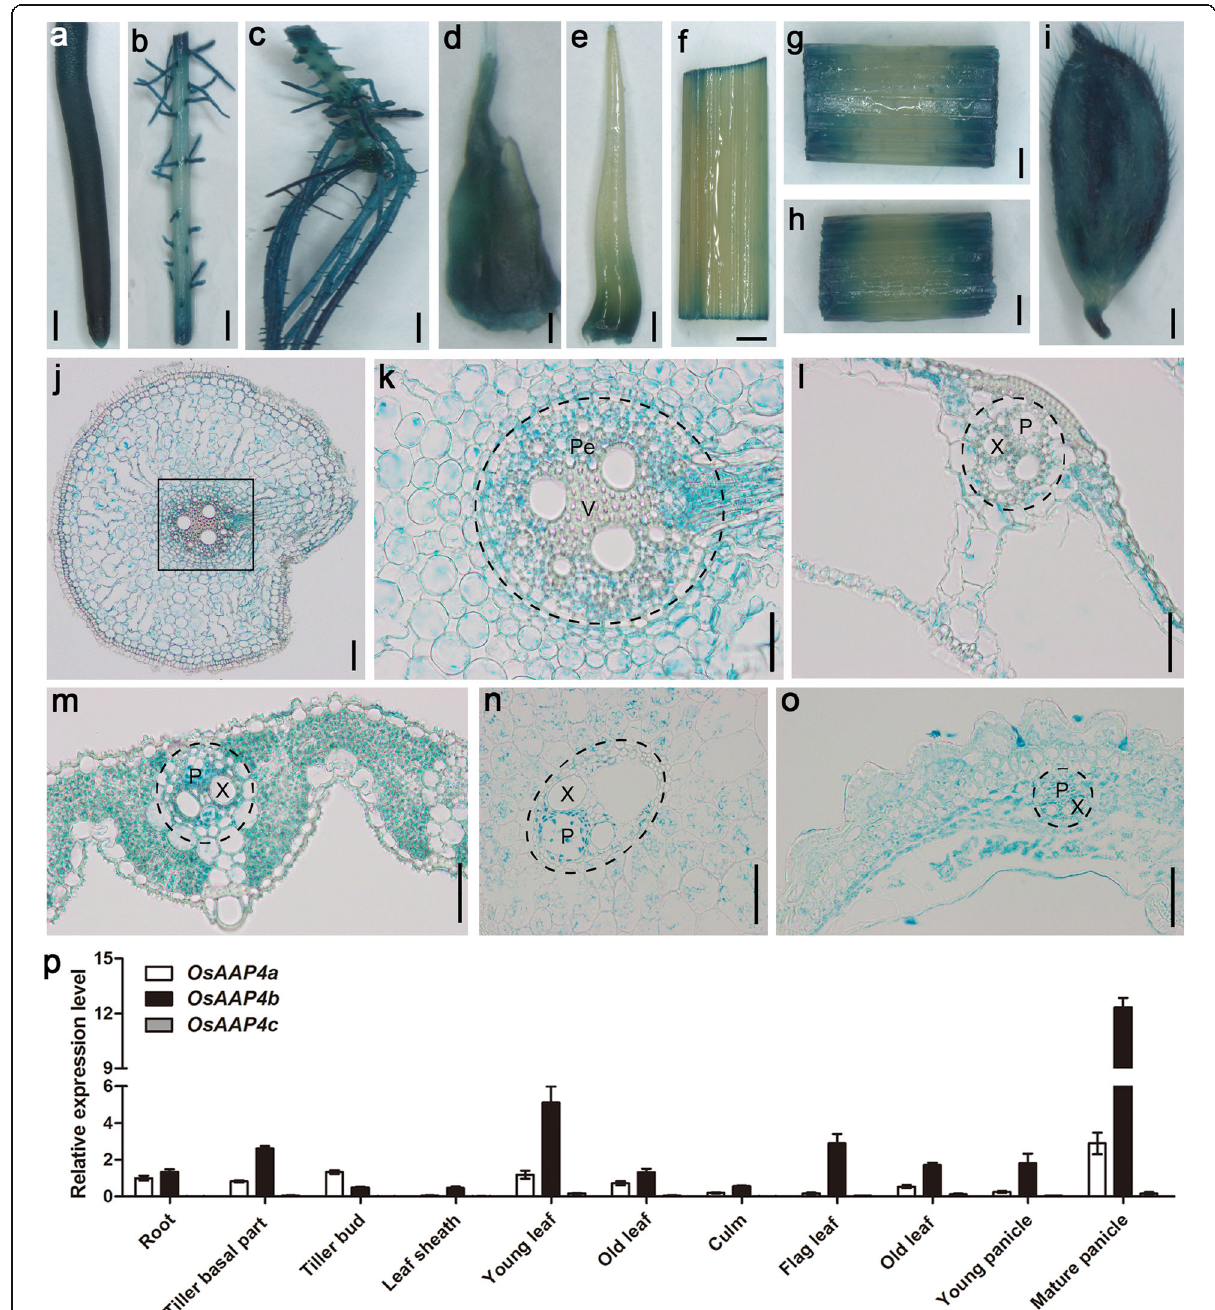
Fig. 2 Promoter-GUS analysis and relative expression level of OsAAP4. OsAAP4 promoter - GUS staining in the root tip ( a ), lateral root ( b ), adventitious roots ( c ), short outgrowth bud ( d ), long outgrowth bud ( e ), leaf blade (f ), leaf sheath ( g ), stem ( h ), and panicle ( i ) using the Hap2- Indica type of p OsAAP4 - GUS- transgenic plants. Transverse section of a root ( j ) and its enlargement ( k ), leaf sheath ( l ), leaf blade ( m ), stem ( n ), and panicle ( o ) using the Hap2- Indica type of p OsAAP4- GUS transgenic plants. p The expression pattern of OsAAP4 in different tissues of Japonica ZH11. The primers used for quantifying OsAAP4a expression was F: TGGCACTCACCCTTGCACAC, and R: CCGTCCACACCGTCCCTTGT, for quantifying OsAAP4b expression was ACTTGAGCTCTCTGCATTGGGT, and R: AGCGGTAGCA ATTGGCGAGGA, and for quantifying OsAAP4b+c expression was TTGCTGCAGGTGTTCGCGCA, ATCGTCCGCAGCACCAGCTTCAG which primers were designed for common sequences between two splice variants OsAAP4b and OsAAP4c . OsAAP4c of the two splice variants accounts for half of the expression level for both the splice variants. Pe indicates pericycle, V indicates vascular, X indicates xylem, and P indicates phloem in ( k - o ). Scale bars, 0.5cm ( a - c , f - h ), 0.2cm ( d ), 0.1 cm ( e , i ), 50.0 μ m ( j ), 20.0 μ m ( k - o